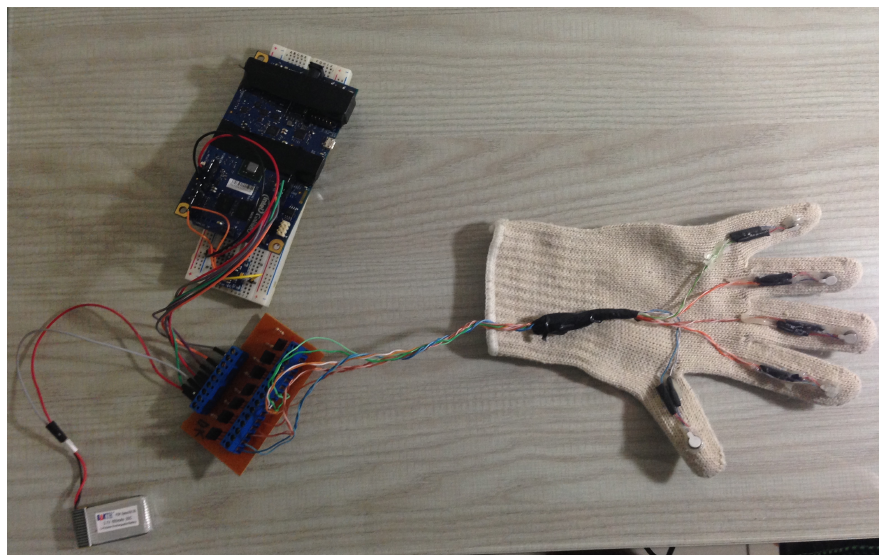
Figure 7. Final version of the